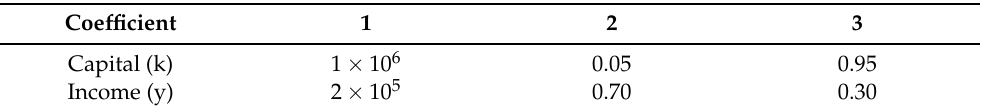
Table 1. Coefficients of Equations (1) and (2) calibrated with data of household income in the U.S. in 2019 published by the U.S. Census Bureau